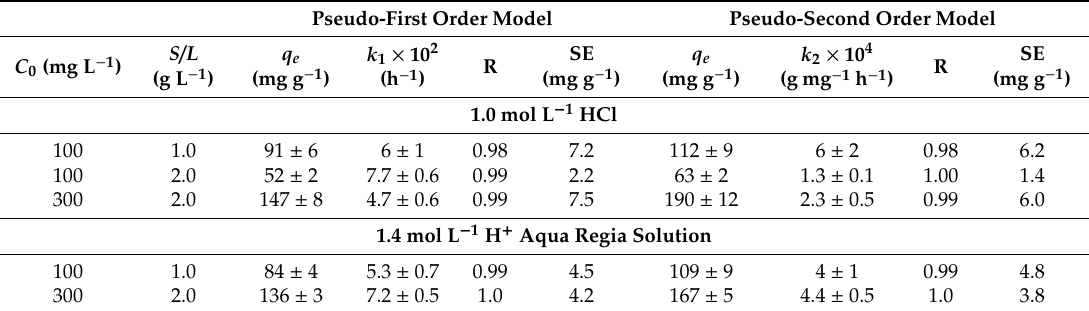
Table 3. Kinetic parameters of reaction-based models ( k , kinetic constants; q e , equilibrium adsorbed amounts) for the adsorption of gold from HCl and aqua regia solutions by the pine bark tannin resin, at 20 ◦ C and for di ff erent initial Au(III) concentrations ( C 0 ) and adsorbent dosages ( S / L